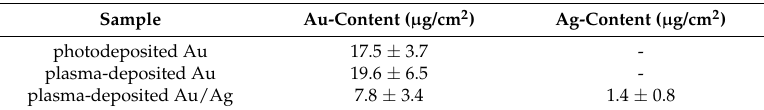
Table 1. Noble metal content of the three